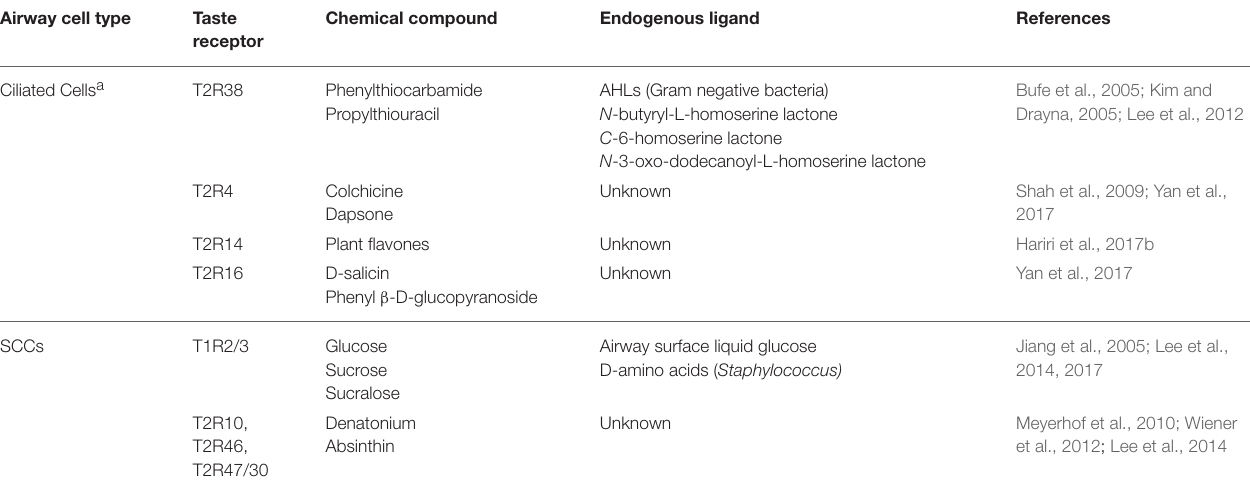
TABLE 1 | Taste receptor ligands in human sinonasal